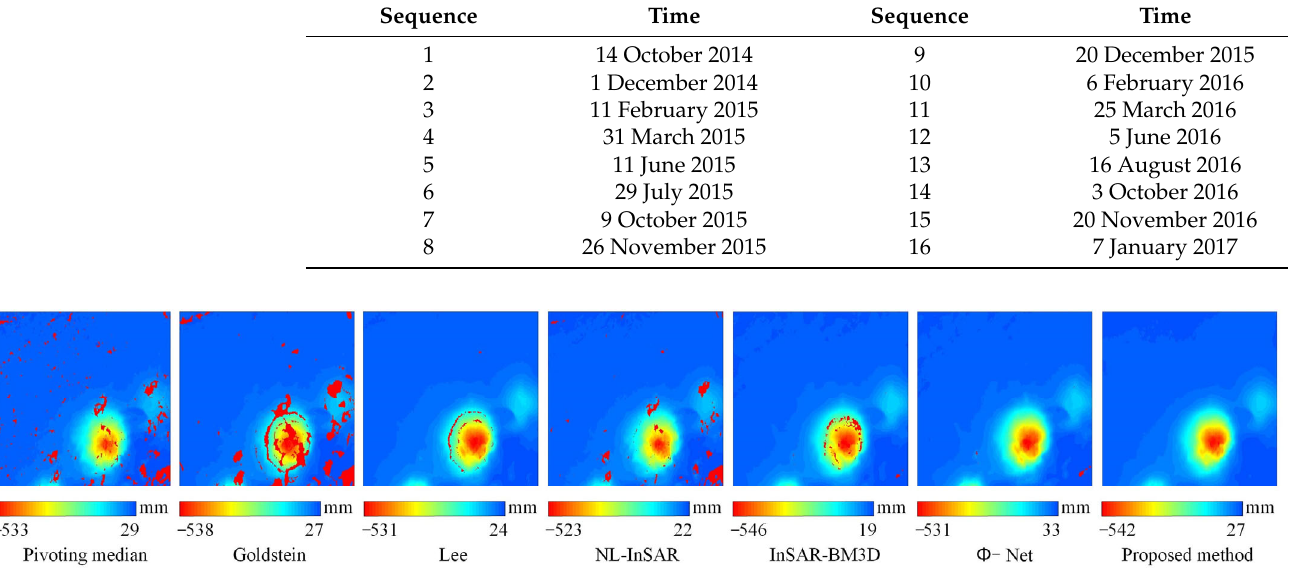
Figure 12. The cumulative settlement from SBAS-InSAR. Table 3. SBAS ‐ InSAR data selection.